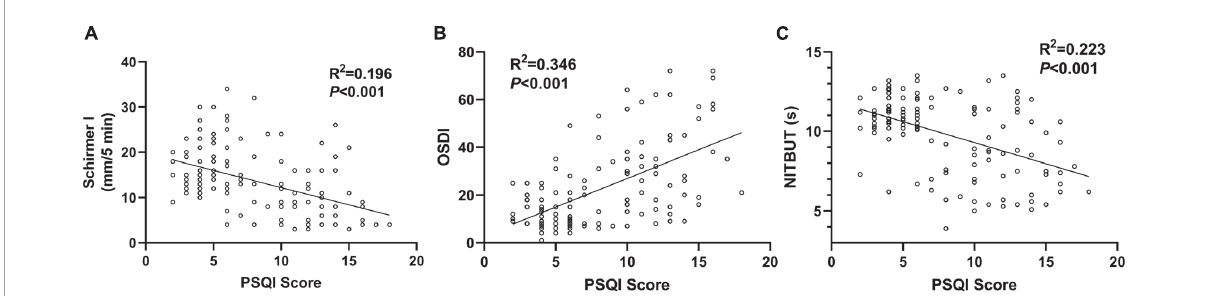
FIGURE2 Associations between PSQI score and DED-related parameters. (A) A negative correlation between PSQI score and Schirmer I test value in the OSA cases ( R 2 = 0.196, P < 0.001). (B) A positive correlation between PSQI score and OSDI score ( R 2 = 0.346, P < 0.001). (C) A negative correlation between PSQI score and NIBUT ( R 2 = 0.223, P < 0.001). All the trend lines were simulated with a linear regression model.